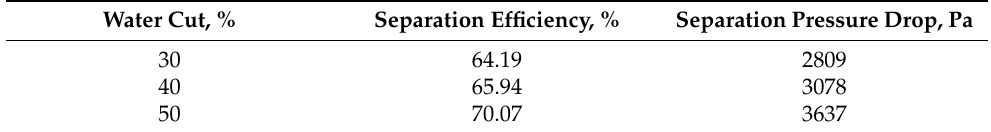
Table 3. Effect of the water cut on the gas–liquid separation performance.